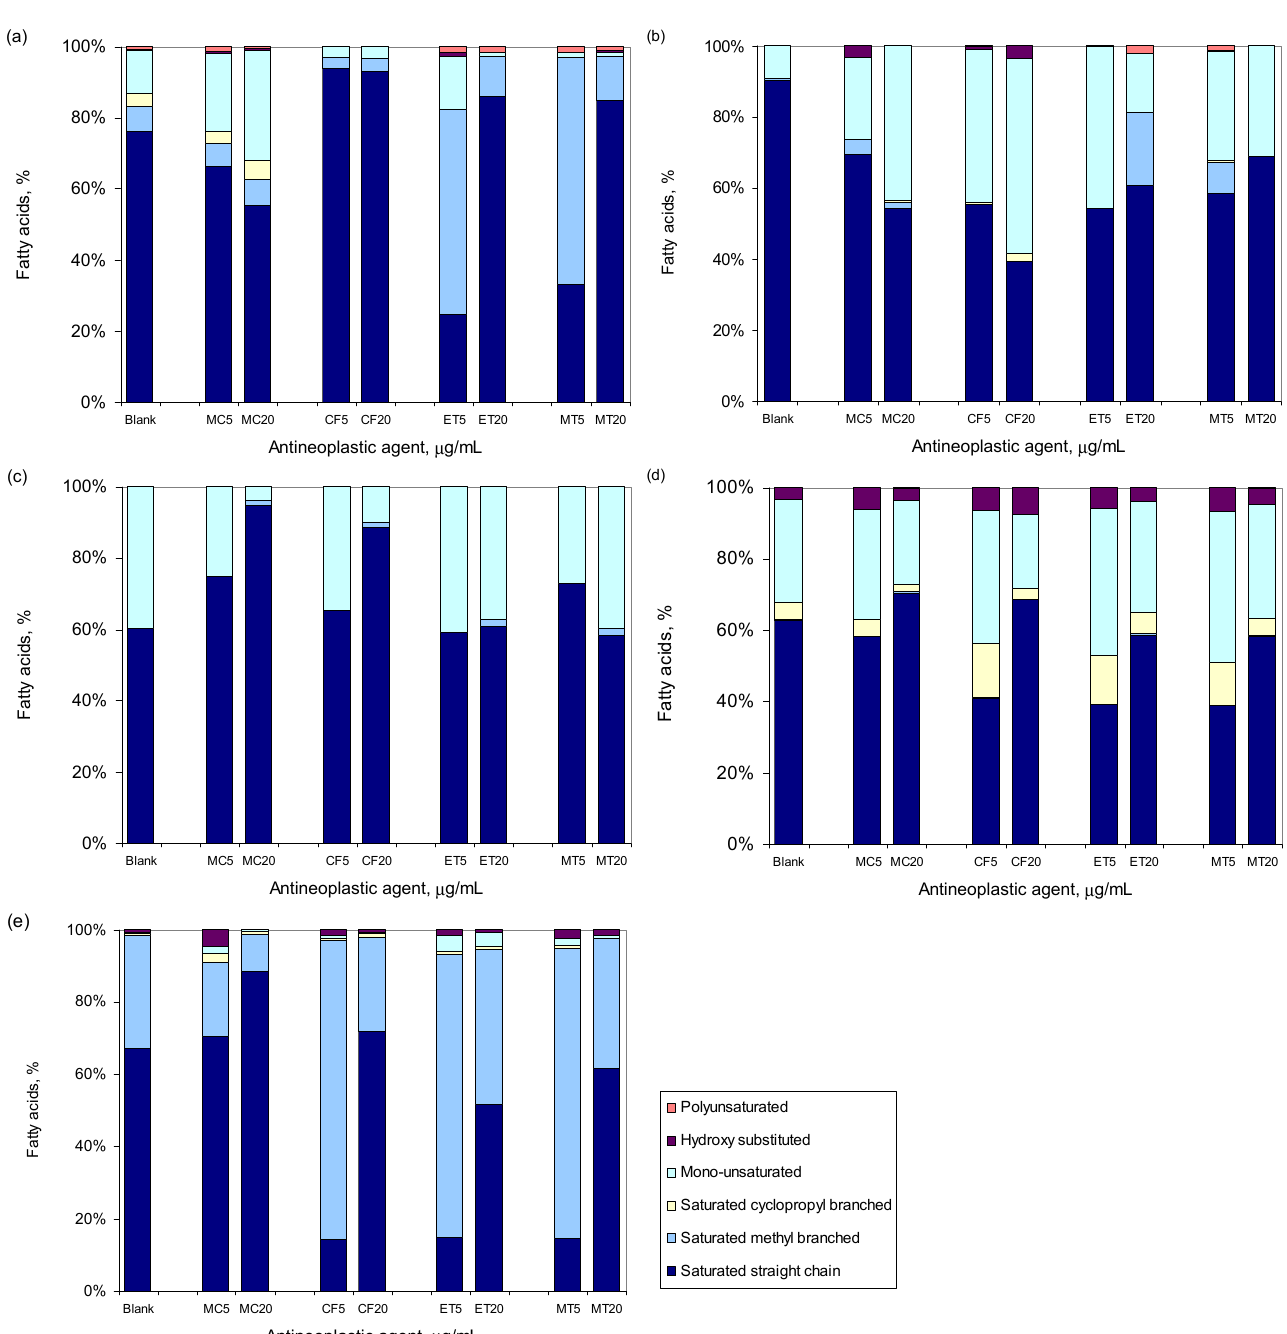
Figure 3. Fatty acid composition of S. aureus ( a ), M. aurum ( b ), M. vaccae ( c ), E. coli ( d ), and P. aeruginosa ( e ) following exposure for 24 h to 5 or 20 µ g/mL of mitomycin C (MC), cyclophosphamide (CF), etoposide (ET), and methotrexate (MT). Blank refers to cells not exposed to antineoplastic agents. Data presented are mean of three independent